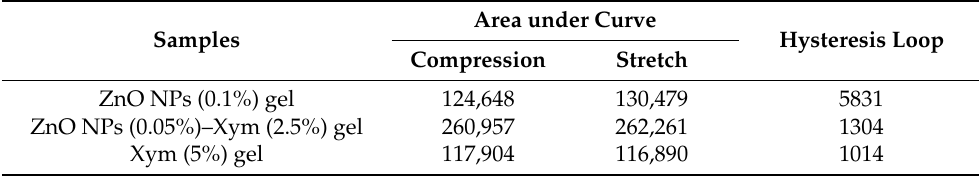
Table 3. Data of structural viscosity